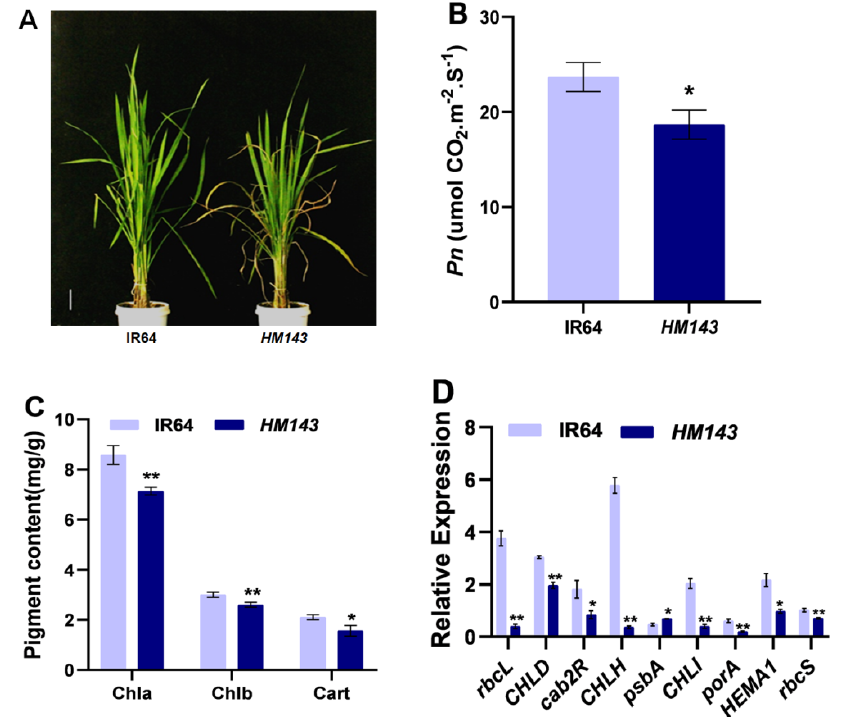
Figure 2. Analysis of leaf senescence in IR64 and HM143 at the tillering stage. ( A ) Phenotypes of IR64 and HM143 at the tillering stage, bar = 17 cm; ( B ) Net Photosynthetic rate ( Pn ); ( C ) Pigment content of IR46 and HM143 ; ( D ) Expression levels of photosynthetic related genes. Data are means ± SD of three biological replicates (Student’s t ‐ test: * p < 0.05; ** p < 0.01).